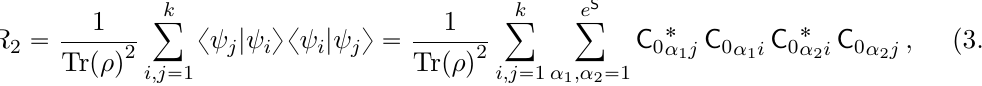
Figure 5 . Purity R 2 as function of k with e S approximation 1